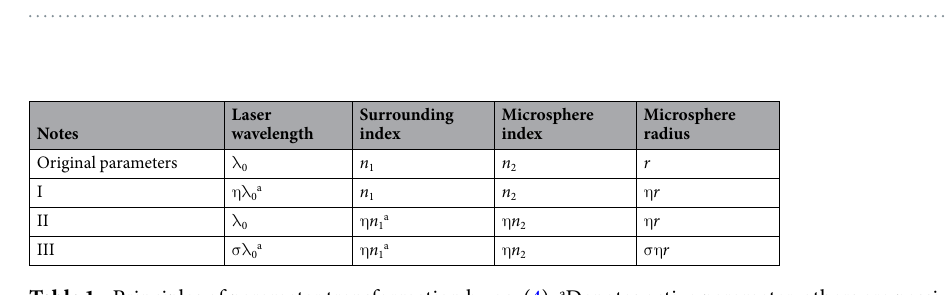
Table 1. Principles of parameter transformation by eq. (4). a Denotes active parameter, others are passive parameters.